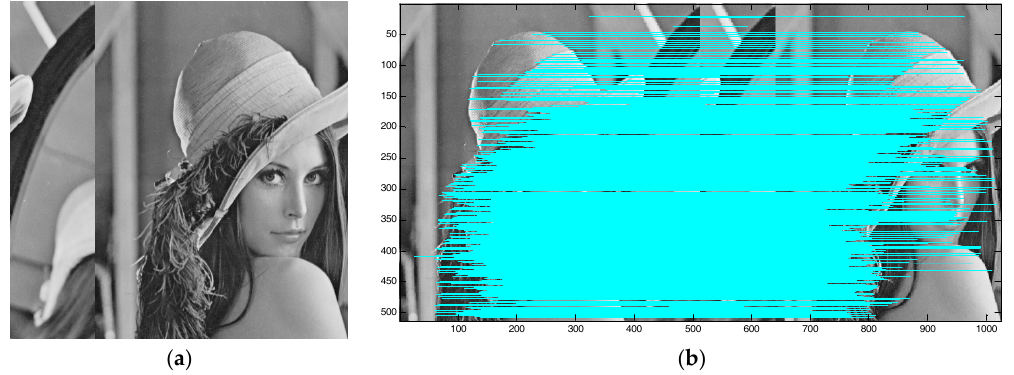
Figure 7. Matching between translated image and watermarked image: ( a ) horizontally translated